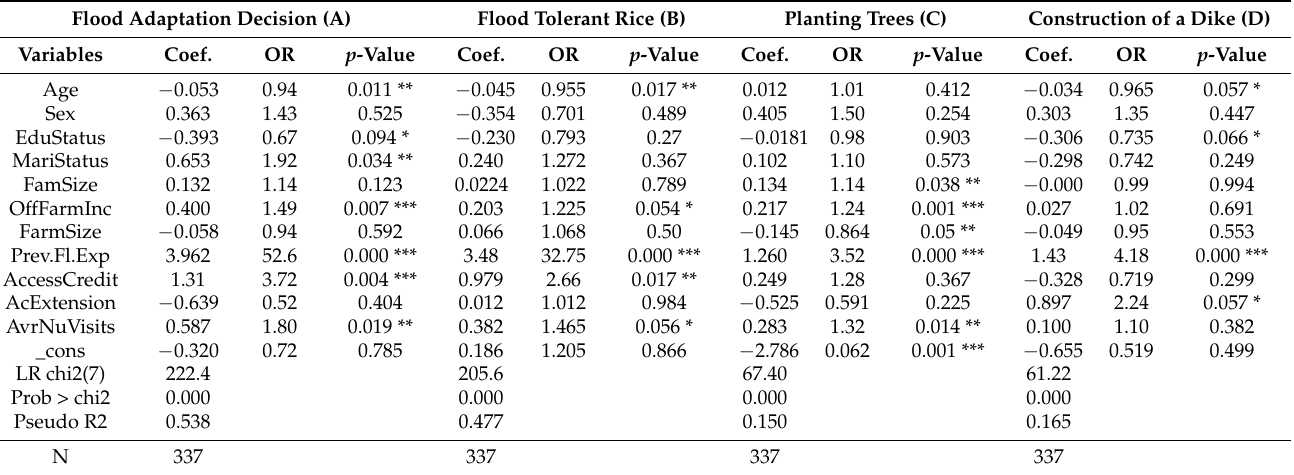
Table 7. Regression Results of the Extended PMT model (Long-Term Adaptation